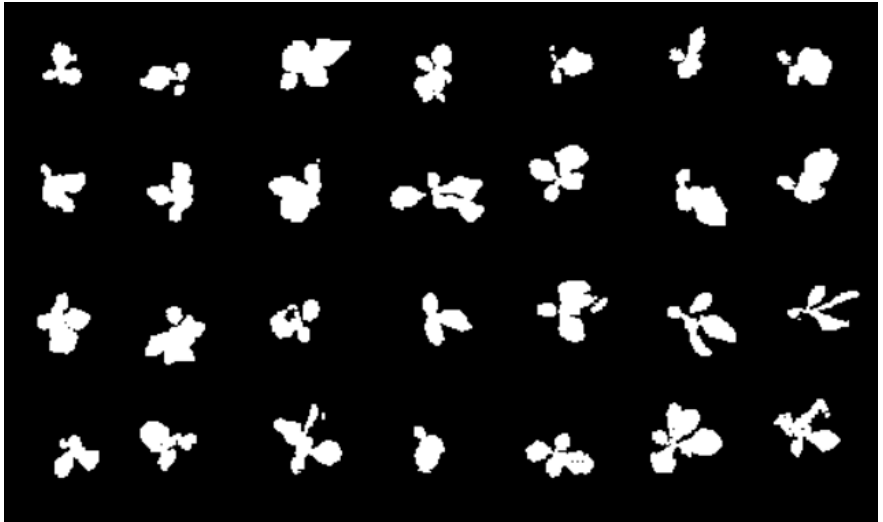
Figure 6. Binary image after de-noising of lettuce plug seedling with seedling age of 17 d.